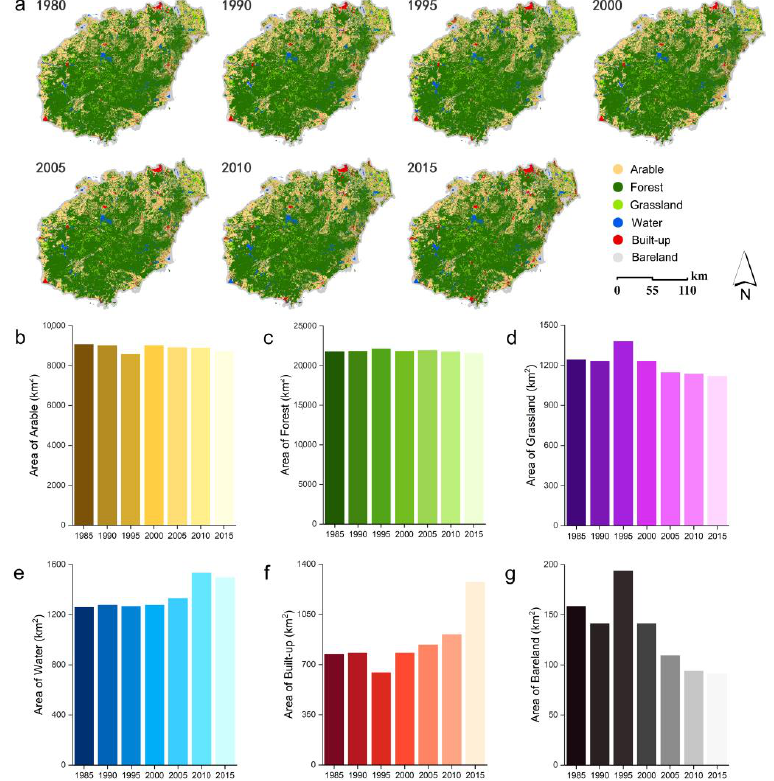
Figure 3. Distribution and long time series area of ecosystem types on Hainan Island from 1980 to 2015. ( a ) Temporal and spatial distribution of ecosystem types on Hainan Island from 1980 to 2015. ( b ) Change in arable area on Hainan Island from 1980 to 2015. ( c ) Change in forest area on Hainan Island from 1980 to 2015. ( d ) Change in grassland area on Hainan Island from 1980 to 2015. ( e ) Change in water area on Hainan Island from 1980 to 2015. ( f ) Change in built-up area on Hainan Island from 1980 to 2015. ( g ) Change in bareland area on Hainan Island from 1980 to 2015.